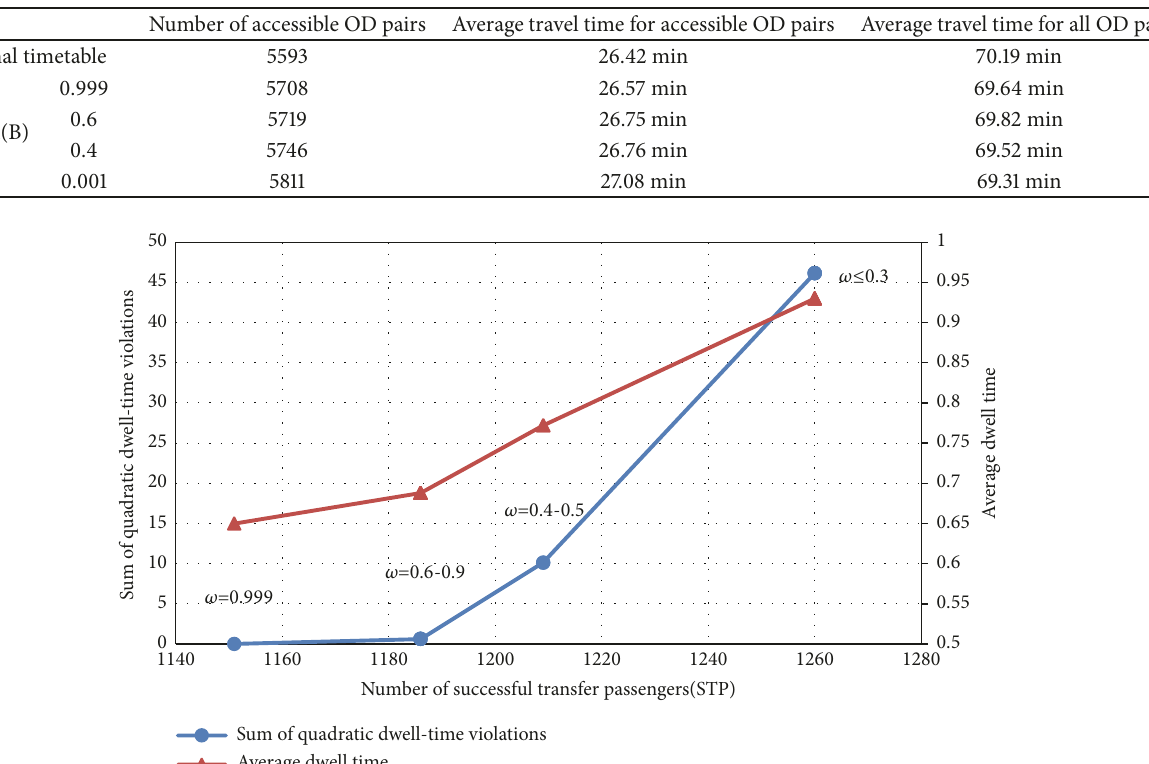
Table 5: Passenger travel time of the optimized last-train timetables.